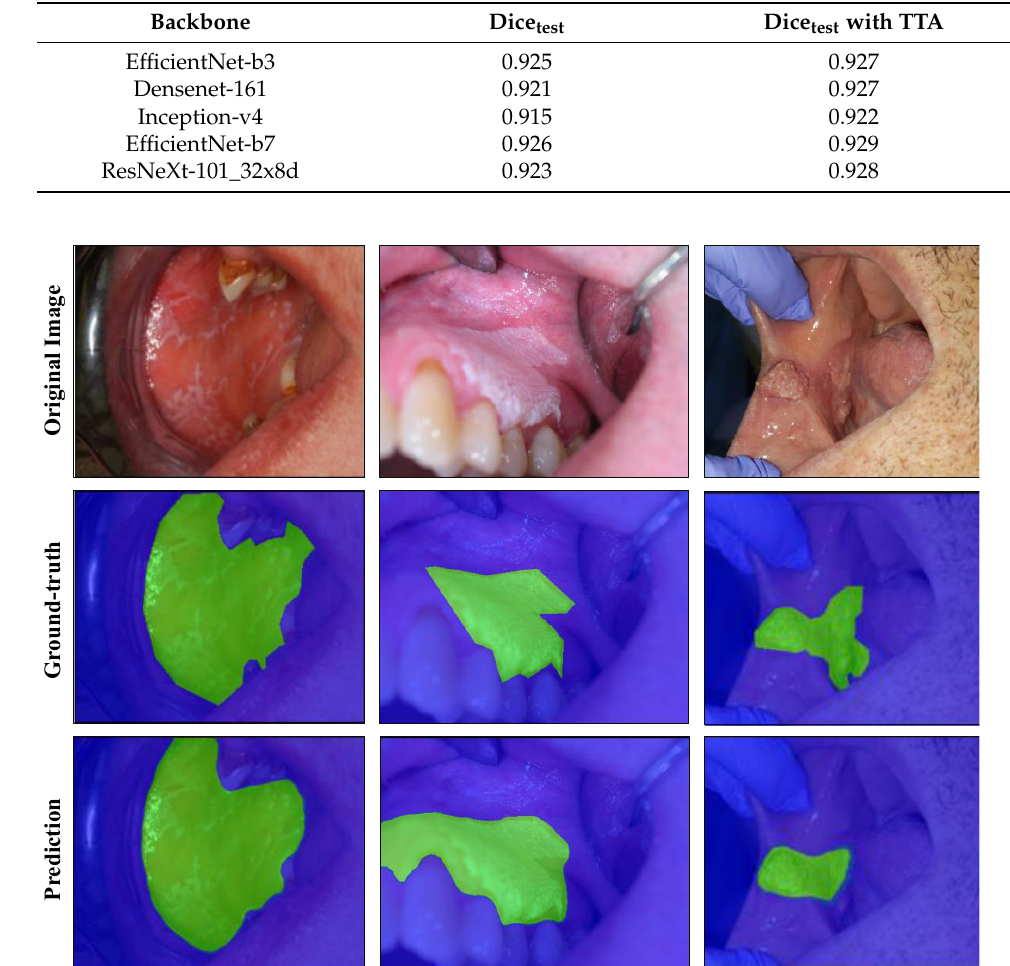
Table 3. Test results of U-Net with various backbones for the background vs. lesion segmentation task. The models were evaluated based on the dice (F 1 ) score as the evaluation metric using the best model checkpoints.